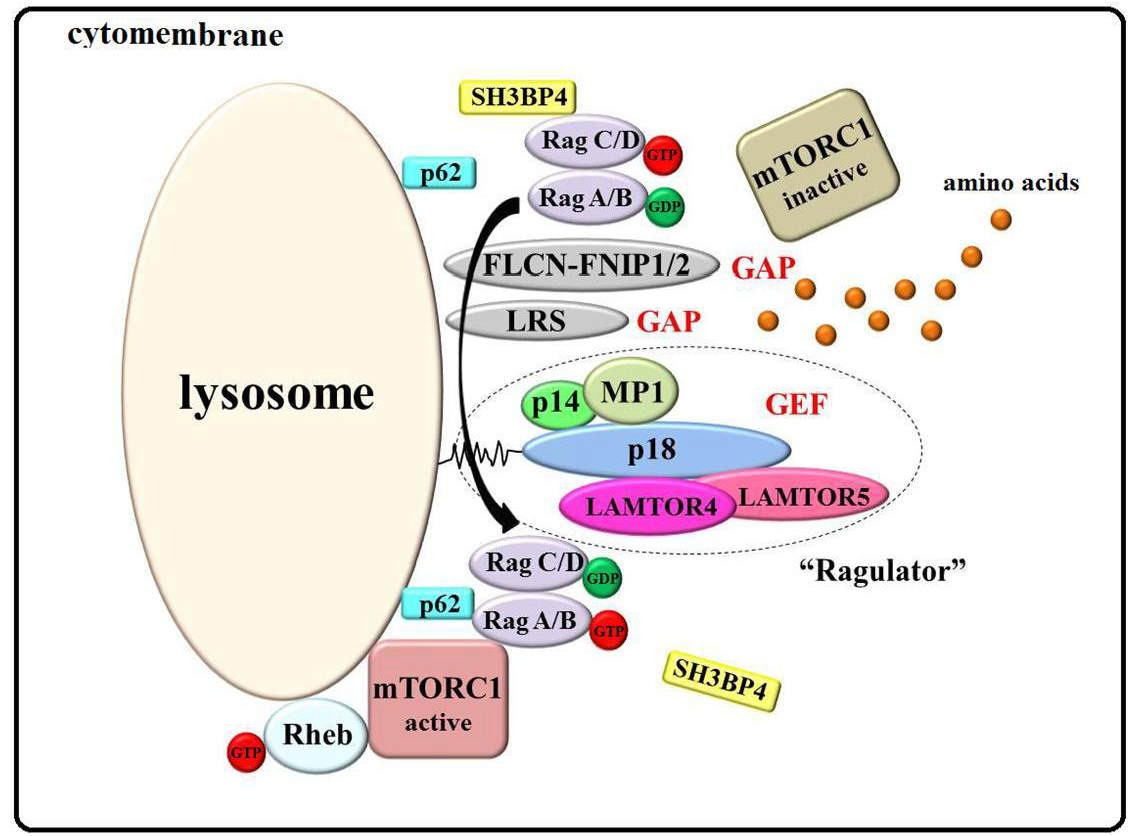
Figure 2. The Ragulator-Rags model of mTORC1 activation by amino acids. Ragulator, a GEF, comprises p14, MP1, p18, LAMTOR4, and LAMTOR5, which localize to the lysosomal surface through p18. Under sufficient amino acids, Ragulator recruits Rag GTPases to the lysosome. Concurrently, amino acids promote the GEF activity of Ragulator for GDP-bound RagA/B and the GAP activity of FLCN-FNIP1/2 and LRS for GTP-bound RagC/D, and active Rag GTPases can recruit mTORC1 to the lysosome to interact with GTP-bound Rheb, which localizes to lysosome, initiating mTORC1 signaling. SH3BP5 is a negative regulator of Rags that interacts with inactive Rag GTPases under amino acid starvation to impede the formation of an active Rag GTPase complex, which inhibits mTORC1 activation. In contrast, p62 binds to Rag proteins to favor the formation and localization of active Rag GTPases, which regulate